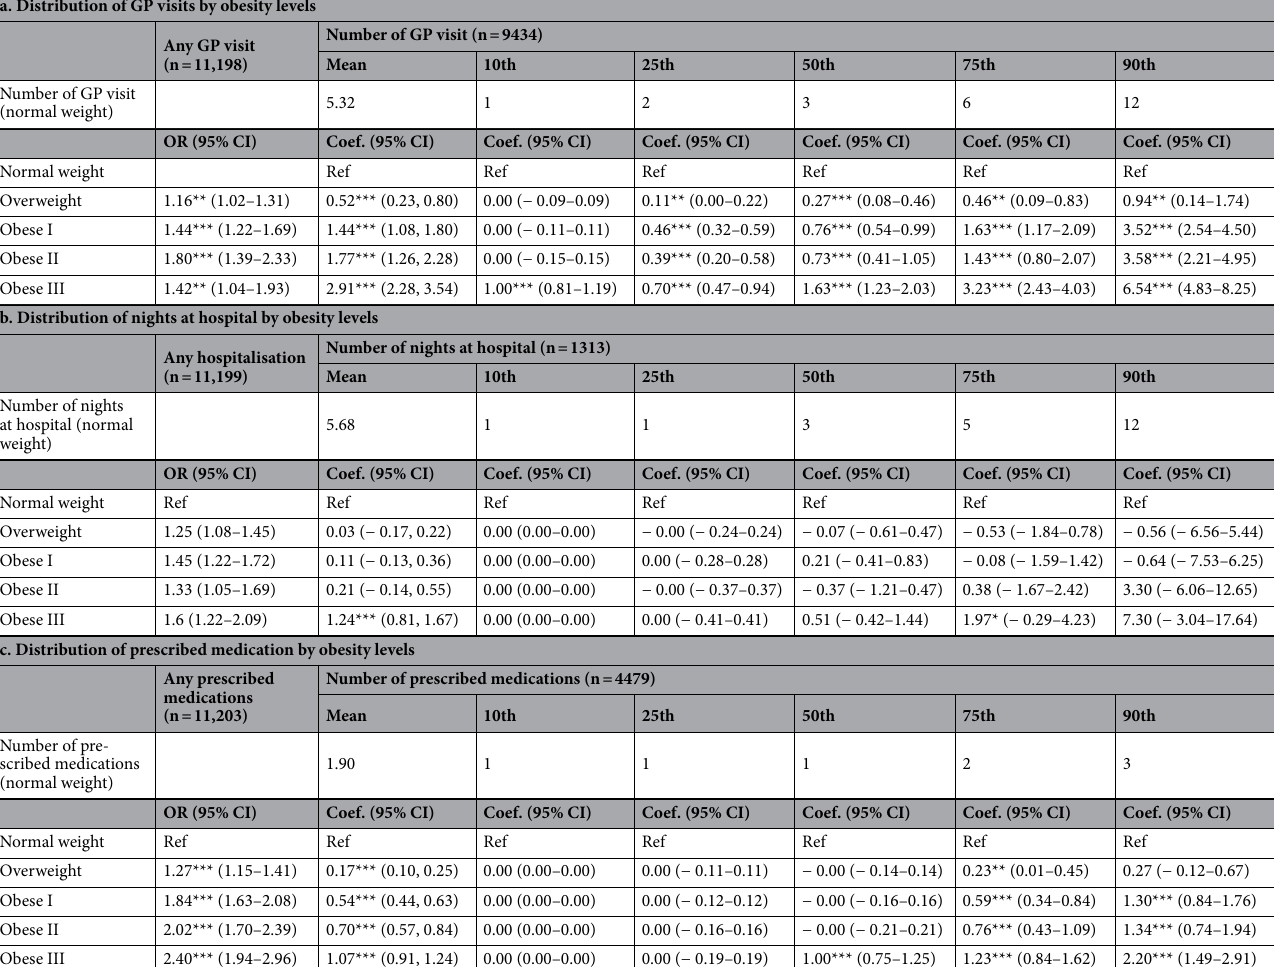
Table 3. Distribution of health service use by obesity levels. Regressions were adjusted for sex, age group, education level, household income, indigenous status, country of birth, marital status, Australian state,